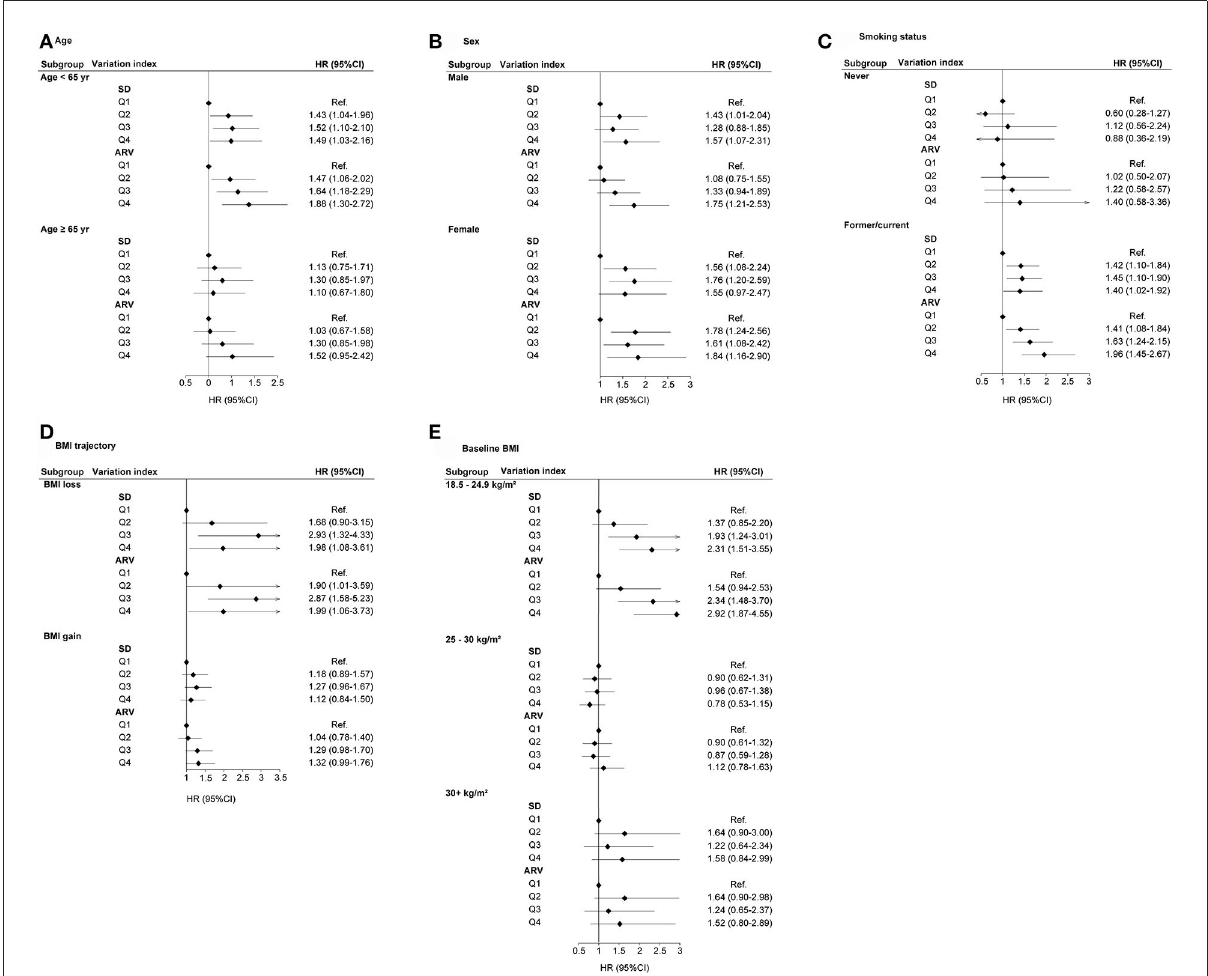
FIGURE3 HR (95% CI) of lung cancer with respect to SD and ARV for BMI variability in subgroups. (A) Age, (B) Sex, (C) Smoking status, (D) BMI trajectory, and (E) Baseline